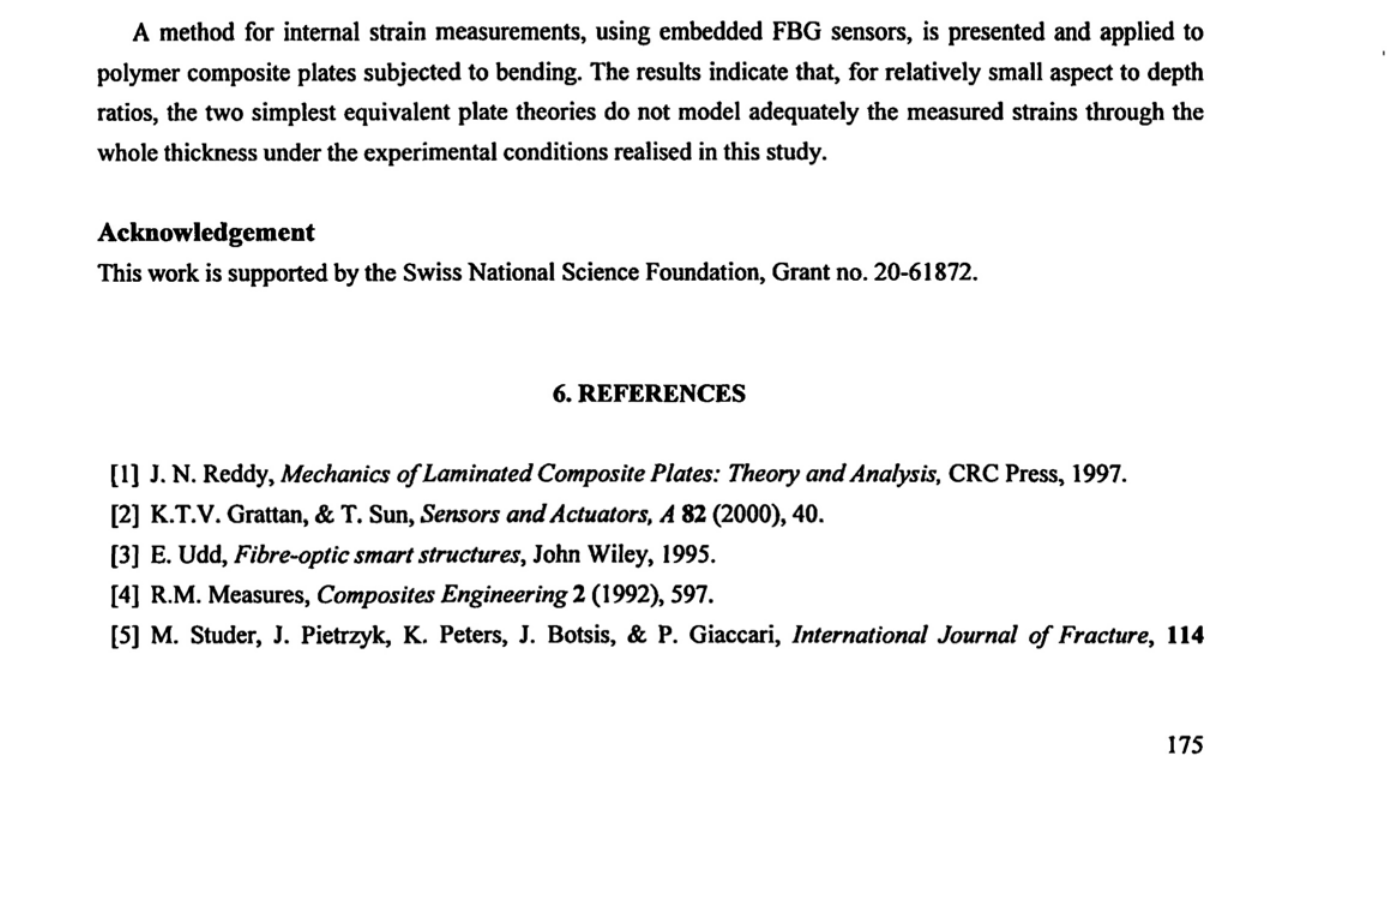
Fig. 6: (a) Through-the-thickness strain distributions per unit load in three point bending with a concentrated load for (a) i/A=10, b/h=2S, /Vh=0, (b) i/A=10, b/h=25,